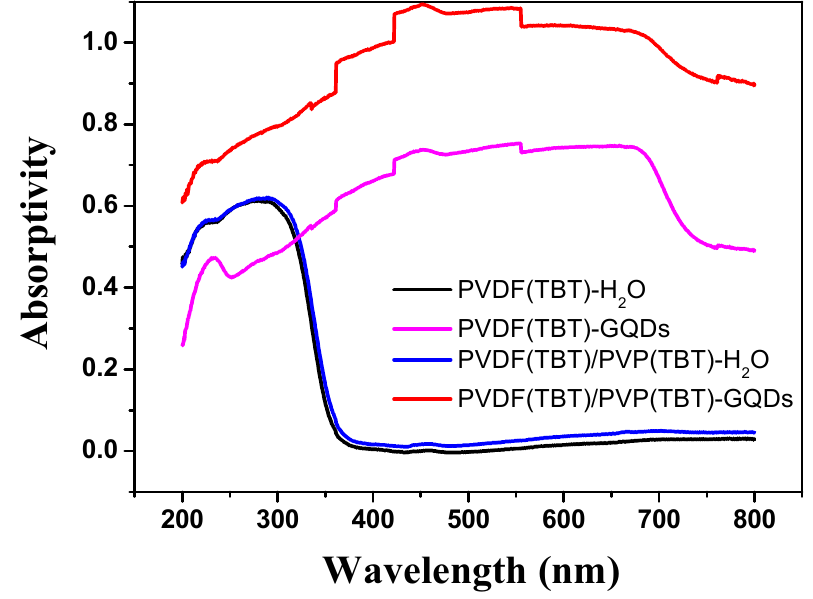
Figure 8. UV–Visible absorption spectra of the PVDF(TBT)-H 2 O, PVDF(TBT)-GQDs, PVDF(TBT)/PVP(TBT)-H 2 O, and PVDF(TBT)/PVP(TBT)-GQDs photocatalyst.